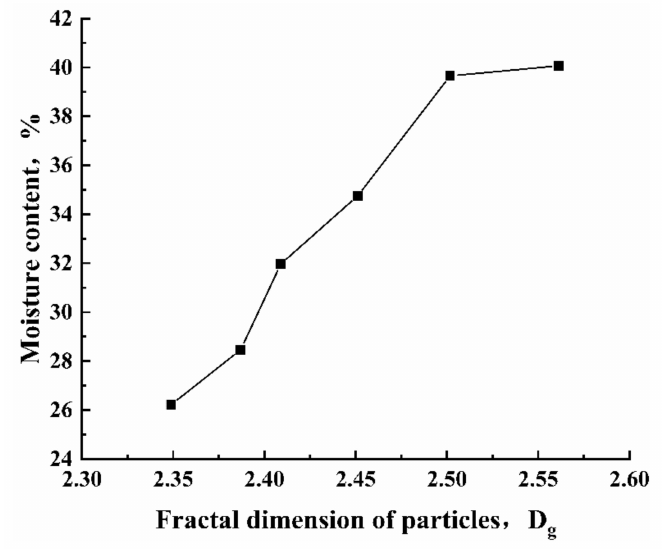
Figure 8. Relationship between fractal dimension and soil moisture content.